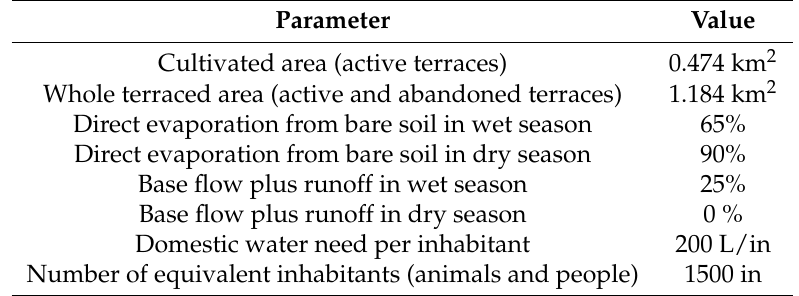
Table 7. Parameters calculated and assumed to derive a water balance at the basin scale.